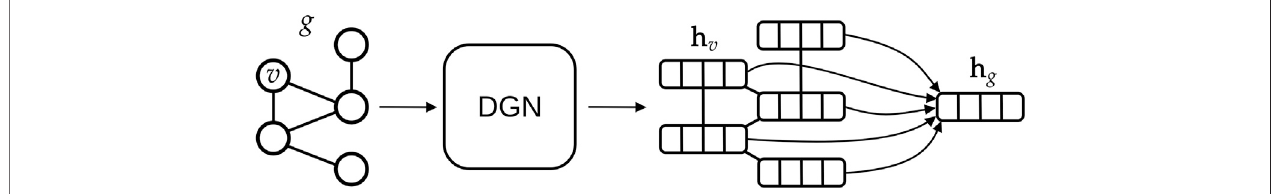
FIGURE6| High-leveloverviewoftypicaldeeplearningmethodologiesforgraphs.Agraph g isgivenasinputtoaDeepGraphNetwork,whichoutputsonevector, also called embedding or state, for each vertex v of the graph. In this study, we aggregate all vertex states via a (differentiable) permutation-invariant operator, i.e., the mean, to obtain a single state that encodes the whole graph structure. Then, the graph embedding is fed into a machine learning regression model (in our case a linear model) to output the S map value associated with g .